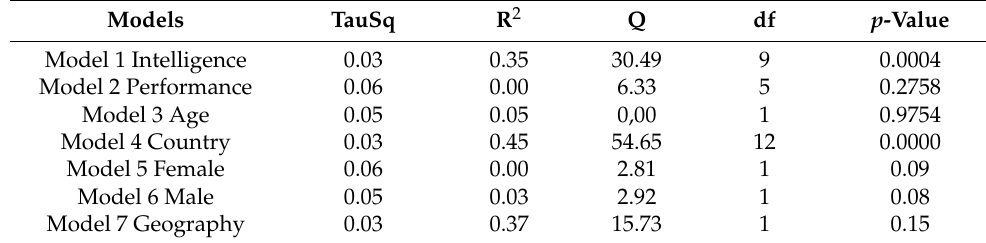
Table 2. Comparison of models: Random effects (MM), Z distribution, Fisher’s Z.